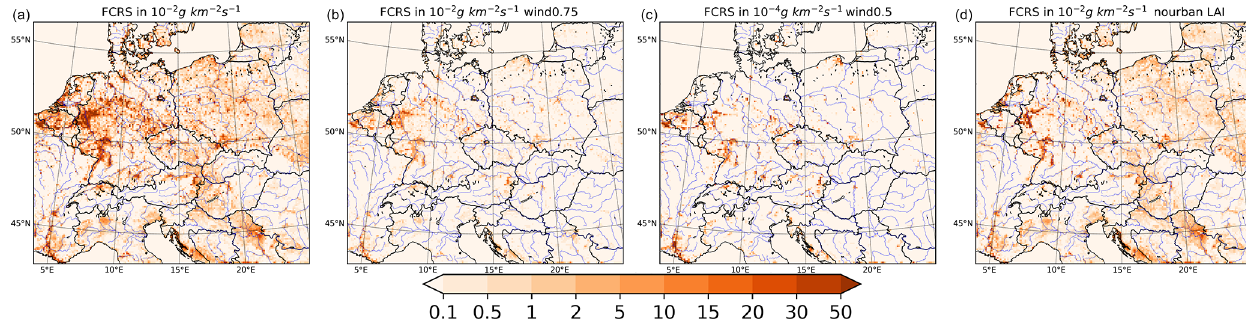
Figure 6. Average WBD emission fluxes of fine crustal material (FCRS) above central Europe in DJF for 2007–2016. From (a) to (d) : the default WBD emissions, WBD emissions after a 0 . 75 × reduction in wind speeds, WBD emissions after a 0 . 5 × reduction in wind speeds and emissions with LAI averaged only over non-urban grid cell fractions. Note that the units for the 0.5 wind reduction have an order of 10 − 4 , while the rest have an order of 10 − 2 .